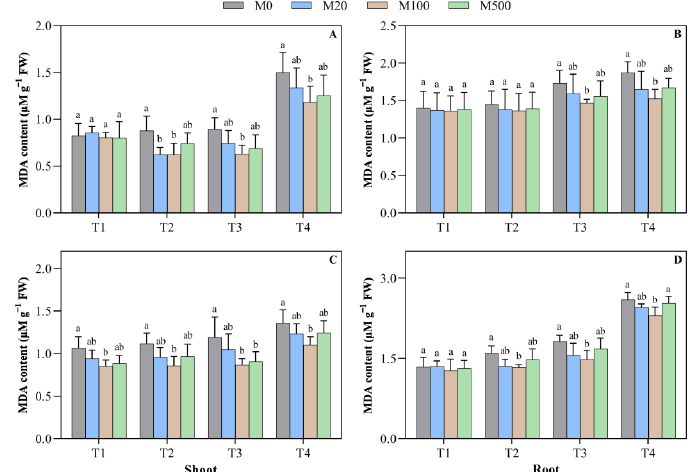
Figure 7. Effects of exogenous melatonin on the malondialdehyde (MDA) content in rice seed germination under high temperature stress. Means ± SEs with different letters in each parameter indicate significant statistical differences ( p < 0.05). ( A ) Malondialdehyde (MDA) content of the shoot (7 d); ( B ) malondialdehyde (MDA) content of the root (7 d); ( C ) malondialdehyde (MDA) content of the shoot (9 d); and ( D ) malondialdehyde (MDA) content of the root (9 d).